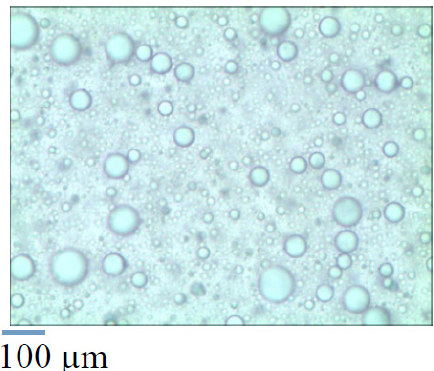
Figure 2. Optical micrograph of the reaction